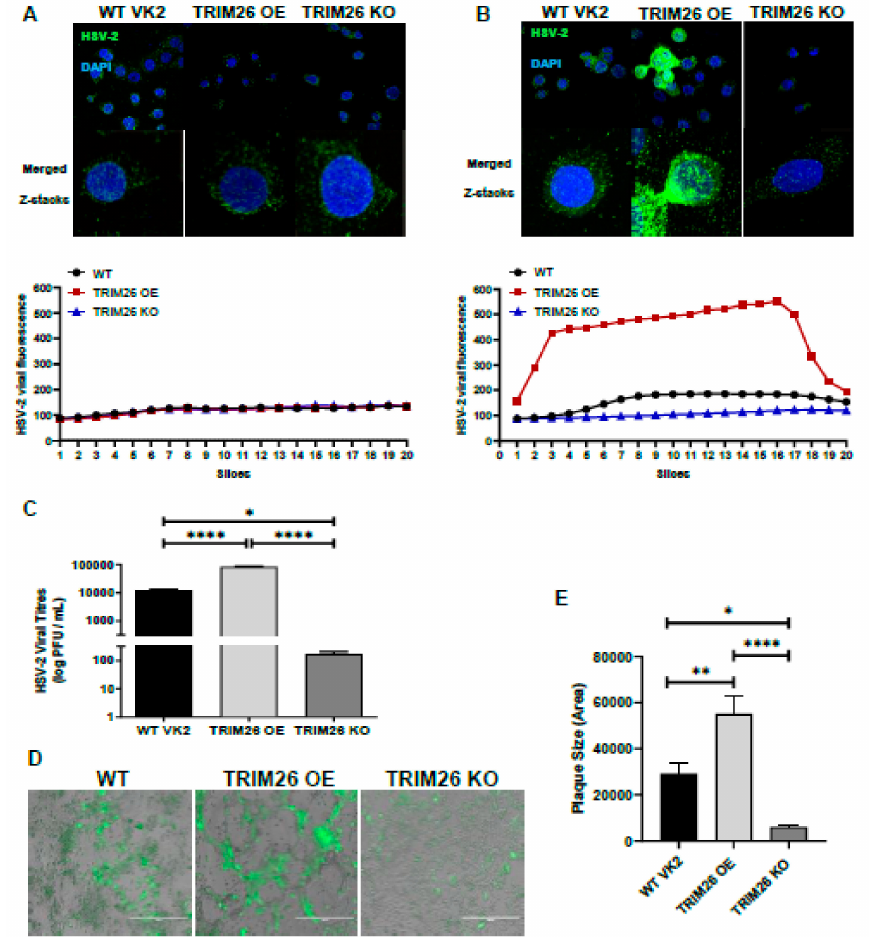
Figure 4. TRIM26 over expression enhances HSV-2 infection of VK2 cells. All three cell lines were exposed to HSV-2 for 2 h at 4 ◦ C and then incubated for ( A ) 2 h and ( B ) 16 h at 37 ◦ C. The cells were fixed and intracellular HSV-2 stained by immunofluorescence (green) and nuclei stained with DAPI (blue), with visualization by confocal microscopy. Top images are views of multiple cells (x630), while bottom images are single cells (x2520) with merge of all signals through the cells (all Z-stacks). Charts below indicate HSV-2 fluorescence ( y -axis) quantitated for each Z-stack slice ( x -axis) from representative single cells above. ( C ) WT VK2, TRIM26 OE and TRIM26 KO cell lines were infected with HSV-2 (MOI = 1) for 24 h. HSV-2 titres were performed using supernatants collected 24 h post infection. Data shown as mean ± SEM ( n = 5). Statistical significance: * p = 0.0002; **** p < 0.0001. ( D ) All three cell lines were infected with HSV2-GFP (MOI = 1) for 16 h before fixation. Cells